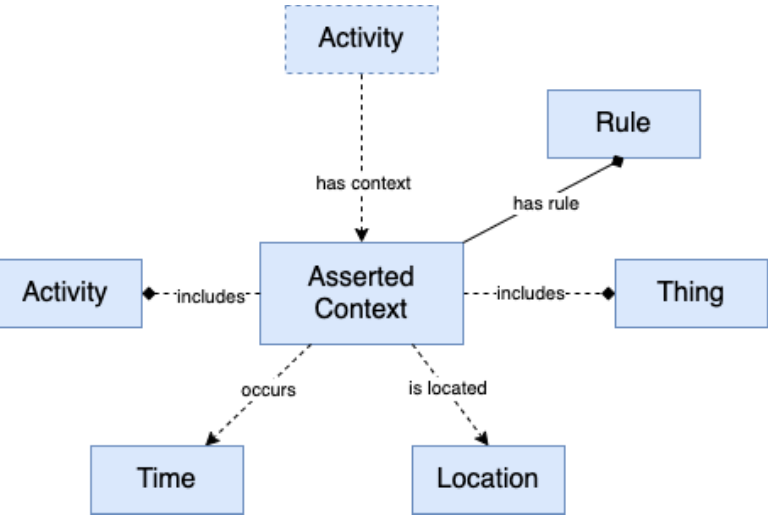
Figure 6. Asserted context class.